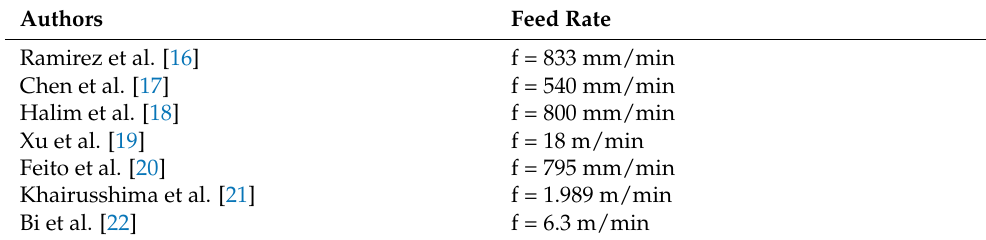
Table 1. The authors and the feed rate applied in tool wear